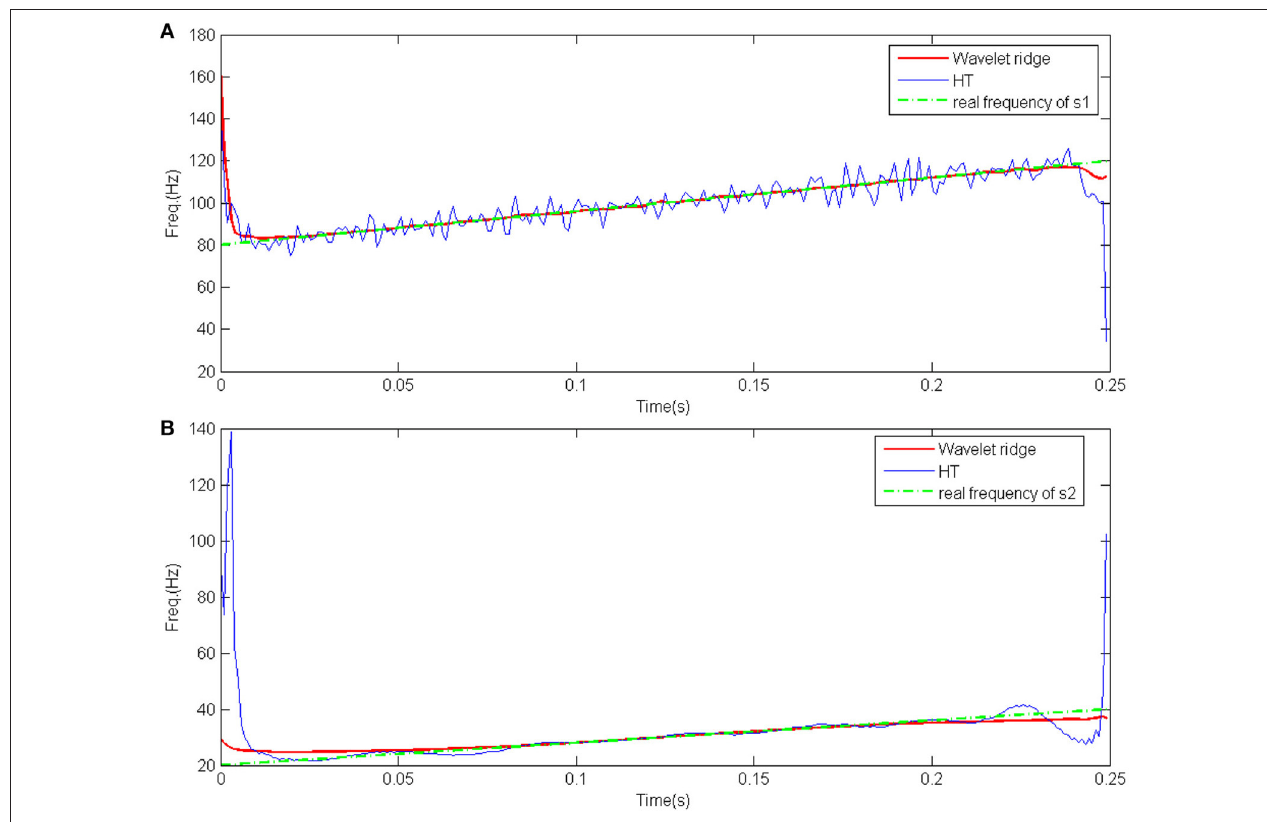
FIGURE 5 | IF extraction of the two IMFs using wavelet ridge and HT with adding Gaussian white noise. SNR is 30 dB. (A) IF of the IMF1. The real frequency of s 1 (t) is plotted in green color. (B) IF of the IMF2. The real frequency of s 2 (t) is plotted in green color.